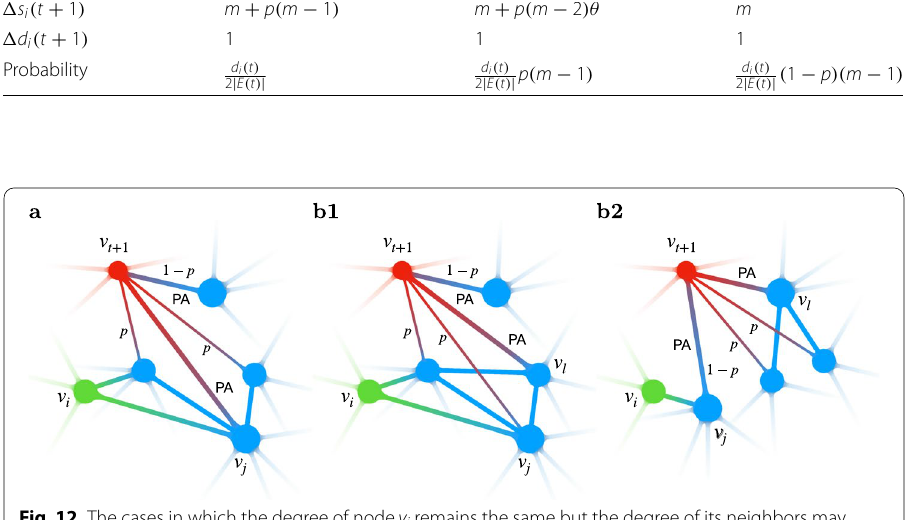
Table 3 The cases in which the degree of node v i changes Step (a) Step (b1) Step (b2)